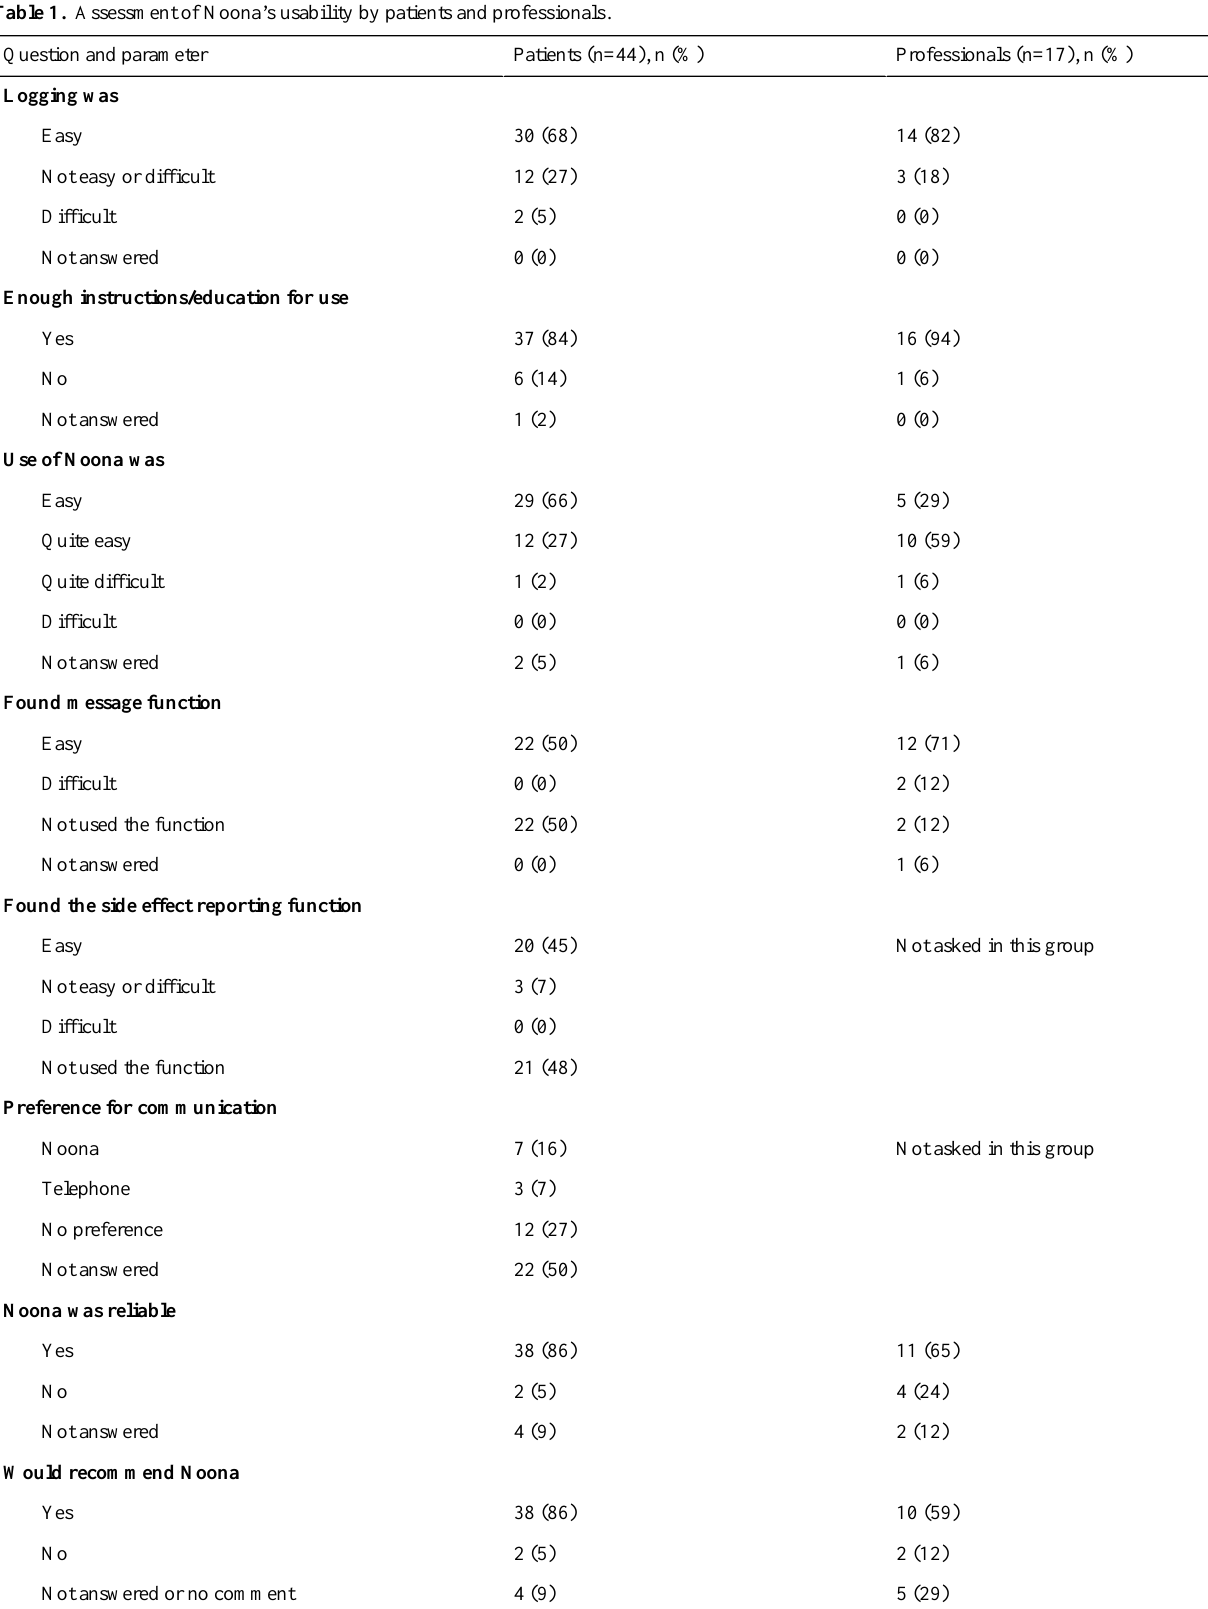
Table 1. Assessment of Noona’s usability by patients and